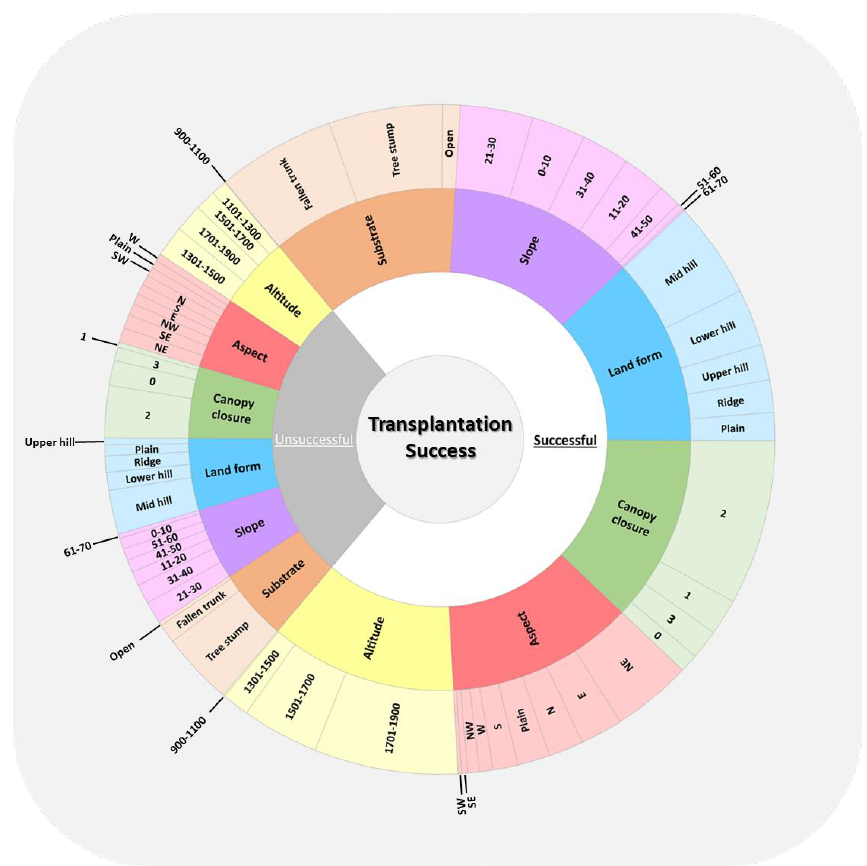
Figure 4. Distribution of Formica rufa nests according to success criteria (inner ring) and habitat parameters (middle and outer rings). The size of each sunburst slice corresponds to the number of nests it includes.